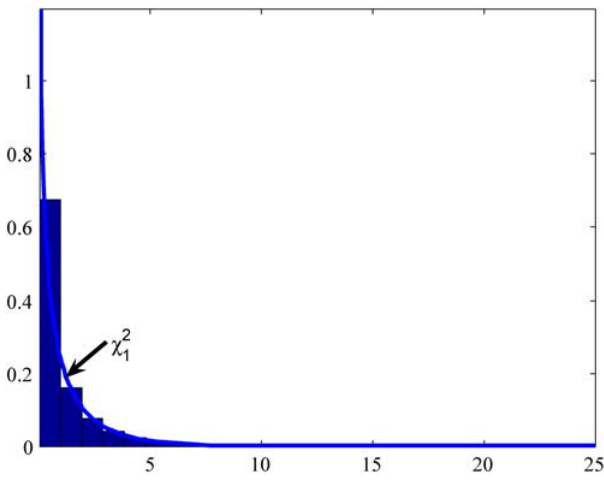
Figure 4. Null Distribution of the statistic T G and controls